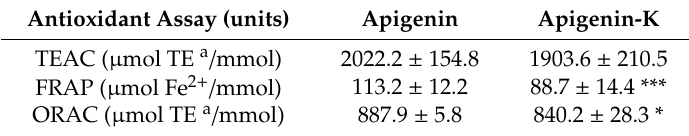
Table 1. Values for di ff erent antioxidant measurements performed with apigenin and apigenin-K. Antioxidant Assay